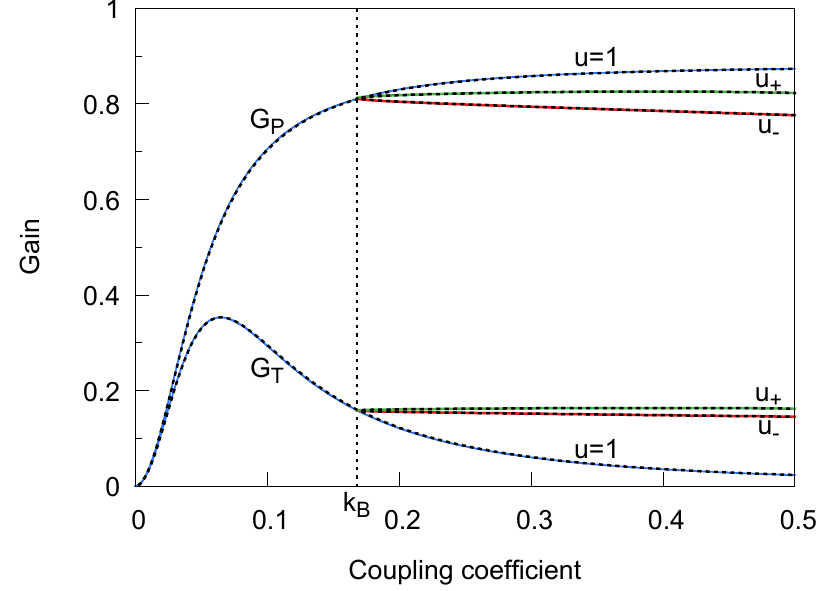
Figure 3. The gains G P and G T at the main resonant frequency u = 1 and the secondary resonant frequencies u ± (for k > k B ), as function of the coupling coefficient k for the example configuration. The solid lines indicate the results for the approximate admittance matrix Y a , the dashed line for the exact admittance matrix Y